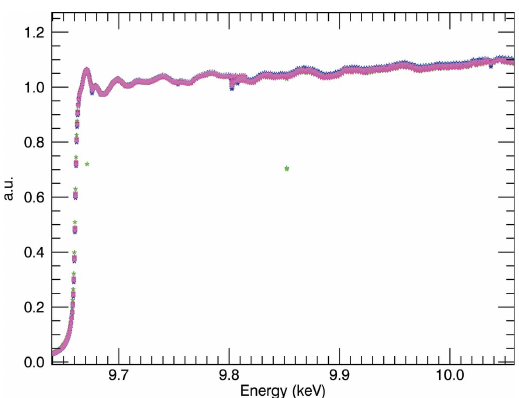
Figure 15 150 K fluorescence data with each pixel corrected for dead-time, normalized by I 0 and edge height, plotted following Fig. 14. The characteristic rising trend almost always seen in fluorescence spectro- scopy is clear and a characteristic signature of absorption of the incident beam, in the